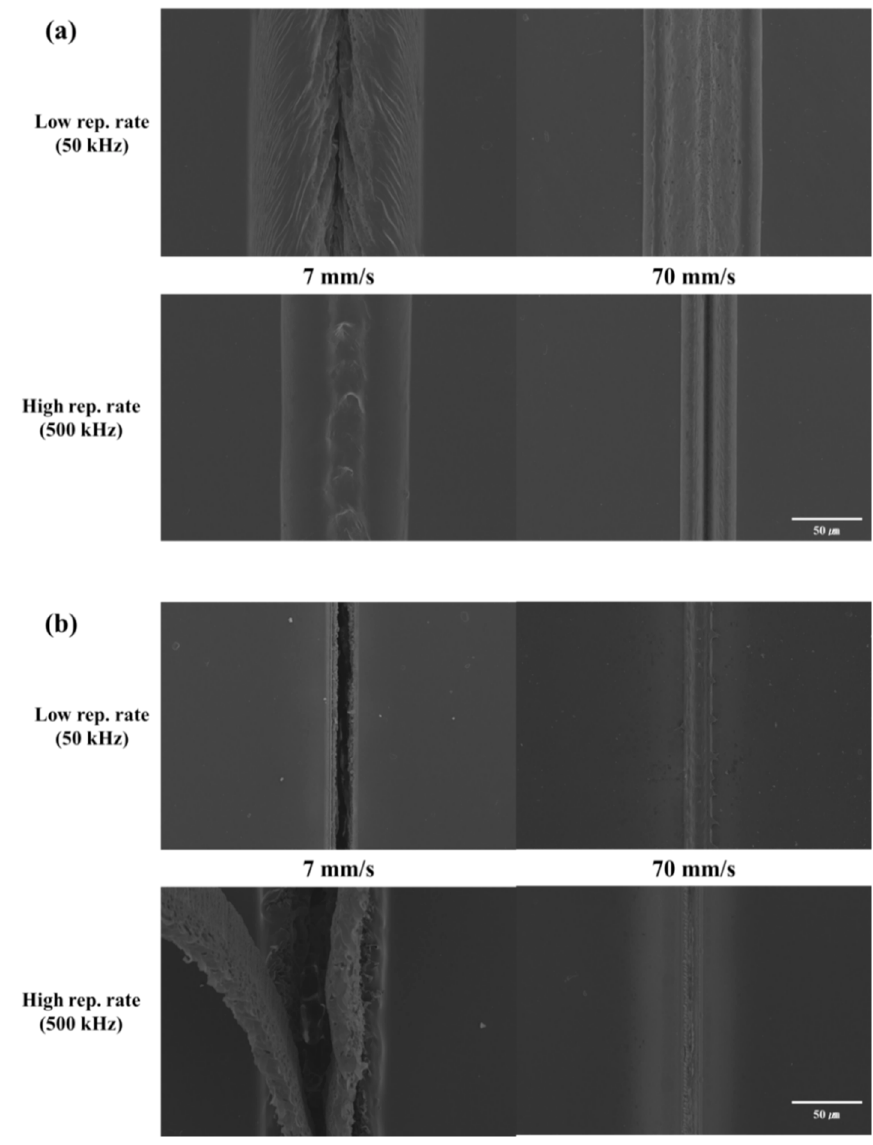
Figure 7. SEM images of laser processing results under stationary beam irradiation with the same pulse energy. ( a ) Polyethylene terephthalate (PET) and ( b ) polyimide (PI).